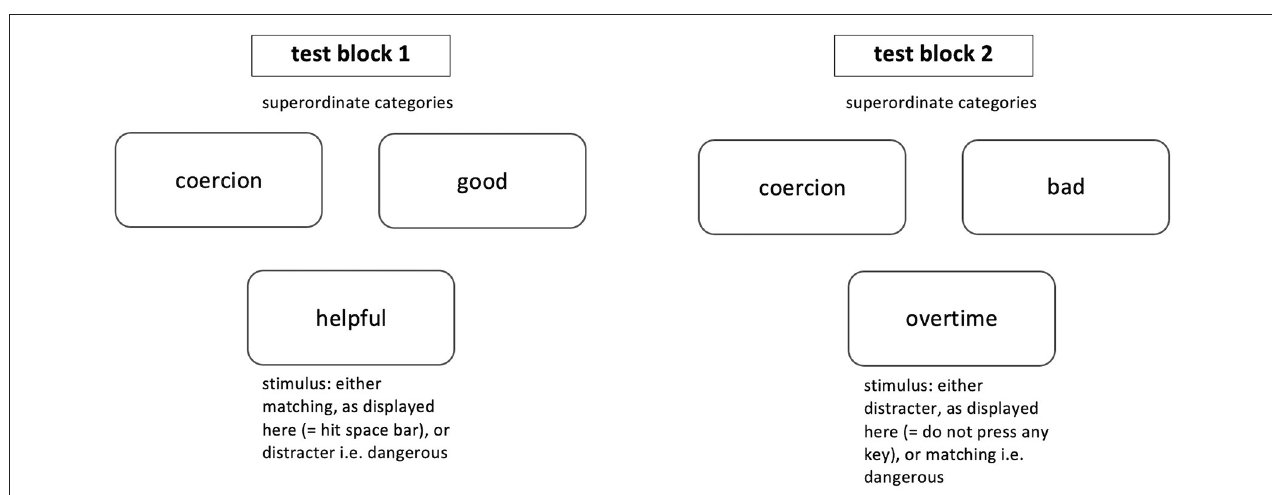
FIGURE 4 | The two critical combined test blocks of the GNAT are displayed. The superordinate categories stay the same throughout one test block, whereas, stimuli change after a deadline is reached or the space bar was